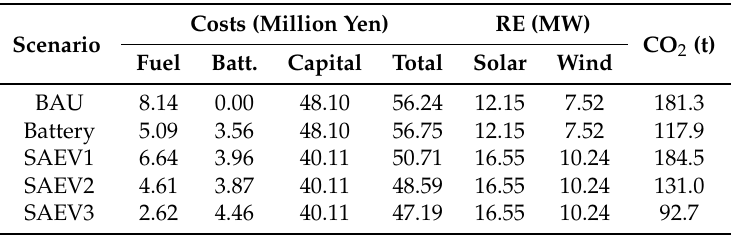
Figure 11. Microgrid case. Sensitivity to total renewable energy (RE) capacity of: ( a ) total costs; and ( b ) carbon emissions. Table 7. Costs and emissions for microgrid scenarios. Fuel includes cost of fuel for cars and cost of dispatchable